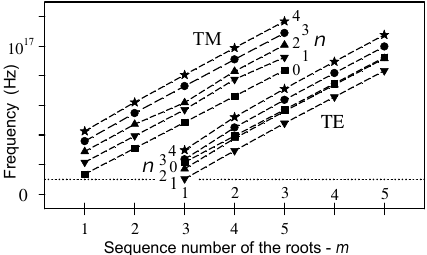
Figure 5. The cutoff frequencies of the inner cavity of a microtubule. The radius of the circular cavity is 8.5 nm. TM and TE are transverse magnetic and electric modes, respectively. The number n is the order of the Bessel function (usually an integer in physical problems) and determines a distribution of the electromagnetic field around the axis in a circular waveguide. The dotted line denotes the lowest frequency 10 16